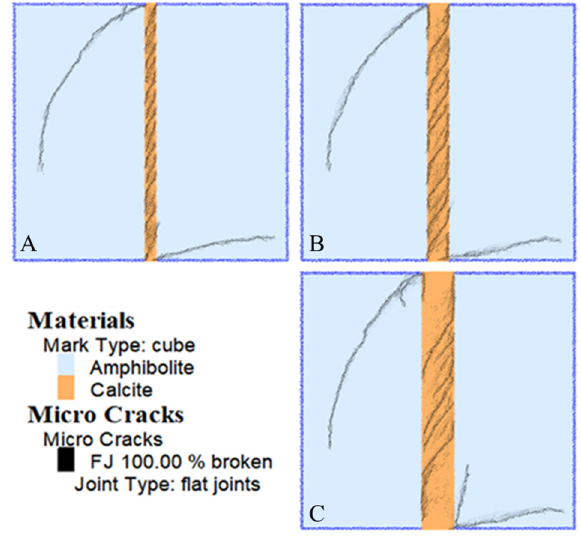
Figure 20. Failure mechanisms in calcite-infilled specimens with calcite-infill thicknesses of ( A ) 4 mm, ( B ) 8 mm, and ( C ) 12 mm.